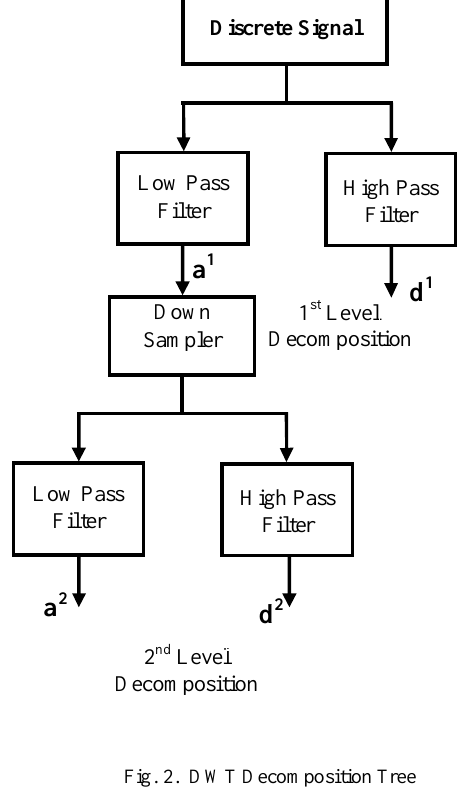
Fig. 2. DWT Decomposition